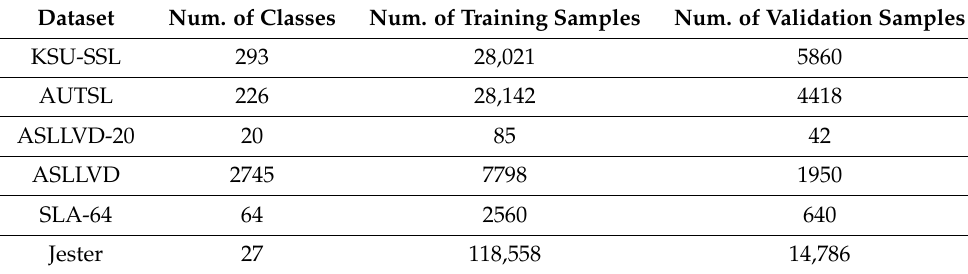
Table 1. Statistics of different datasets used in this